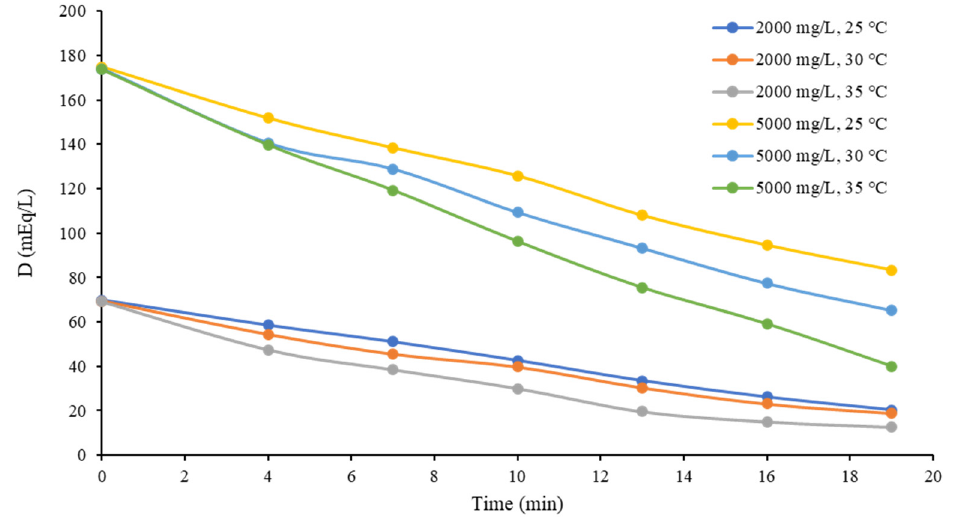
Figure 7. Diluate stream concentration over time at 10 V.